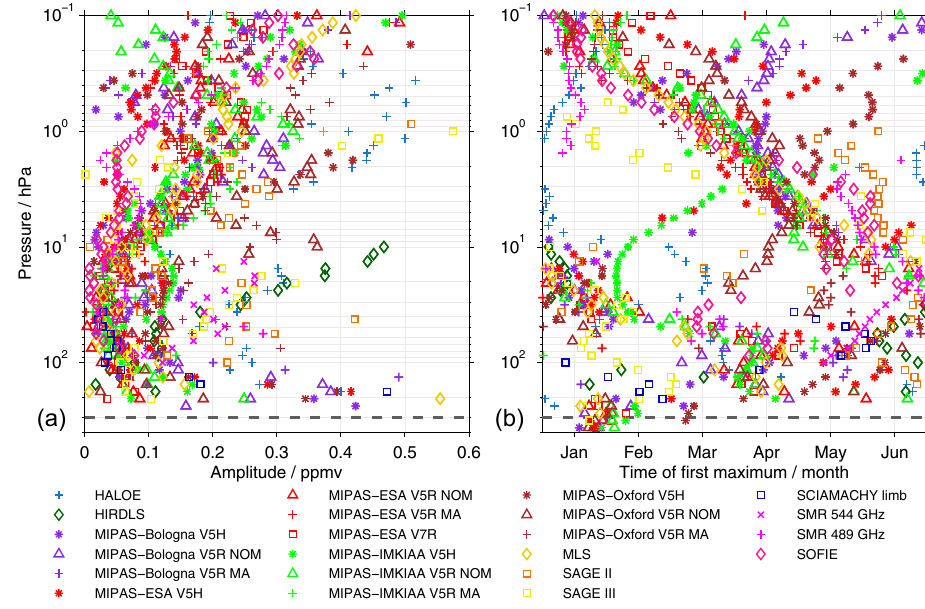
Figure 8. As Fig. 7 but here the results for the latitude range between 70 and 80 ◦ N are shown.